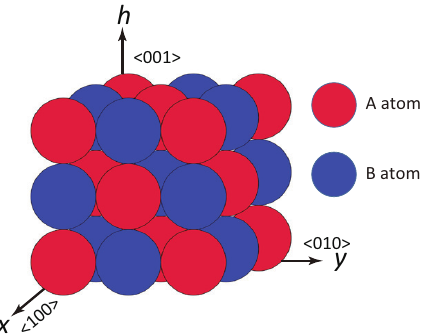
Figure 1. Perspective view of an AB compound with the NaCl crystal